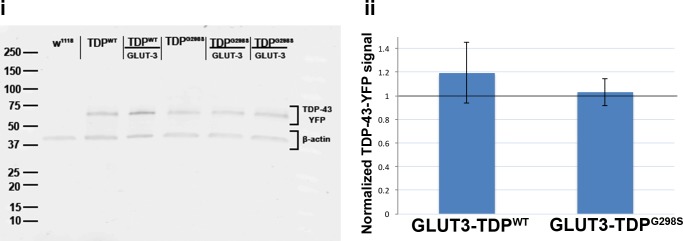
GLUT-4 overexpression mitigates locomotor defects when TDP-43 is expressed in motor neurons or glia but not muscles.(i) Western blot of ventral nerve cords probing for TDP-43-YFP and β-actin. D42 motor neuron driver was used to express TDP-43 in motor neurons. (ii) Quantification of 3 western blot bioreplicates. Protein levels measured by GFP western blot (to detect TDP-YFP) are shown as a ratio between GLUT-3-TDPWT-YFP to TDPWT-YFP alone and GLUT-3-TDPG298S-YFP to TDPG298S-YFP alone.10.7554/eLife.45114.018Figure 4—figure supplement 4—source data 1.Western Blot Quantifications.